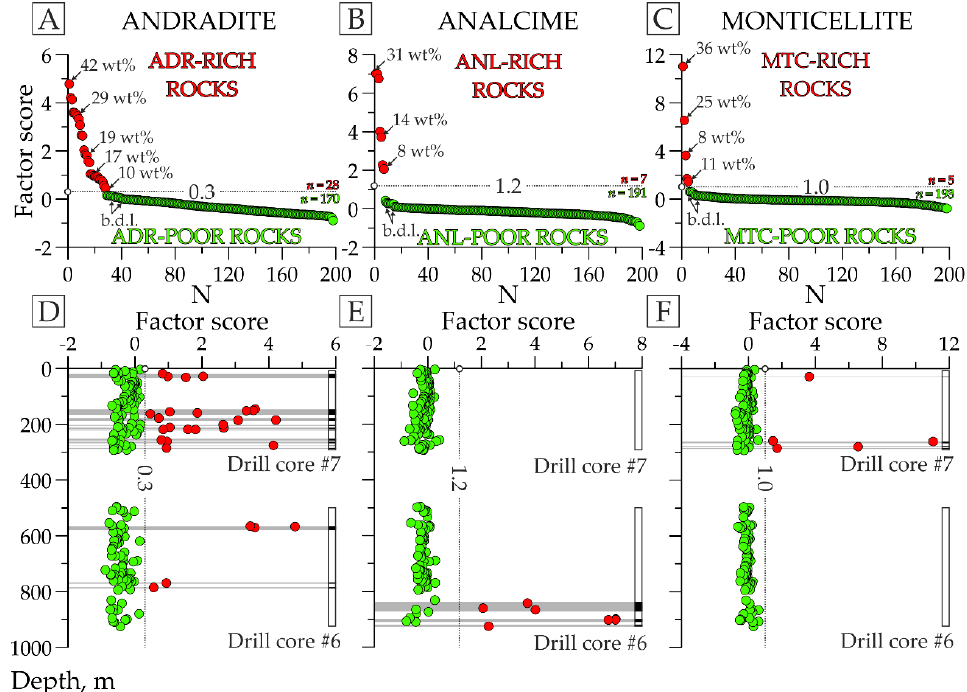
Figure 6. The ranked range of FS s for ( A ) andradite, ( B ) analcime, and ( C ) monticellite (the contents of the corresponding minerals in some samples are indicated); the FS distribution for ( D ) andradite, ( E ) analcime, and ( F ) monticellite in the drill cores. Figure from [39].